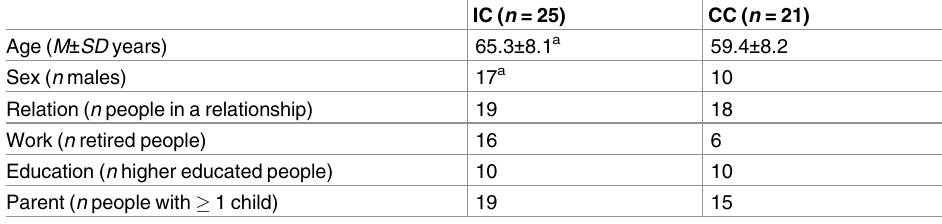
Table 2. Demographic baseline